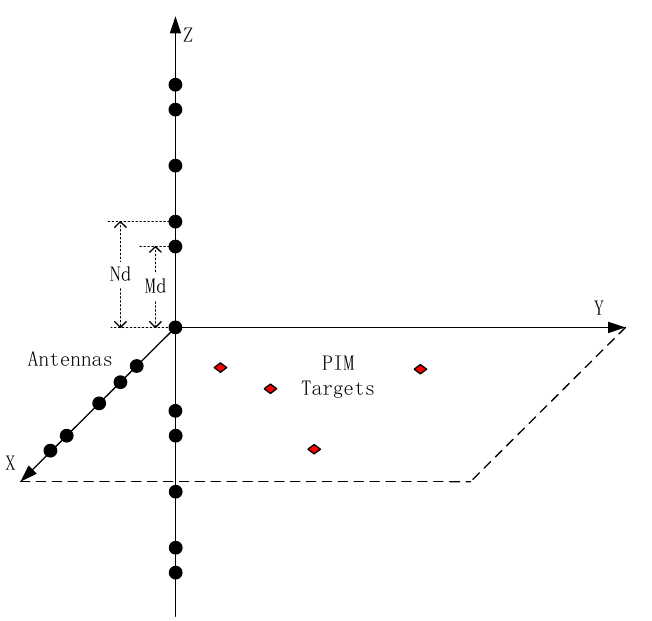
Figure 2. The diagram of detecting PIMs based on CS imaging.